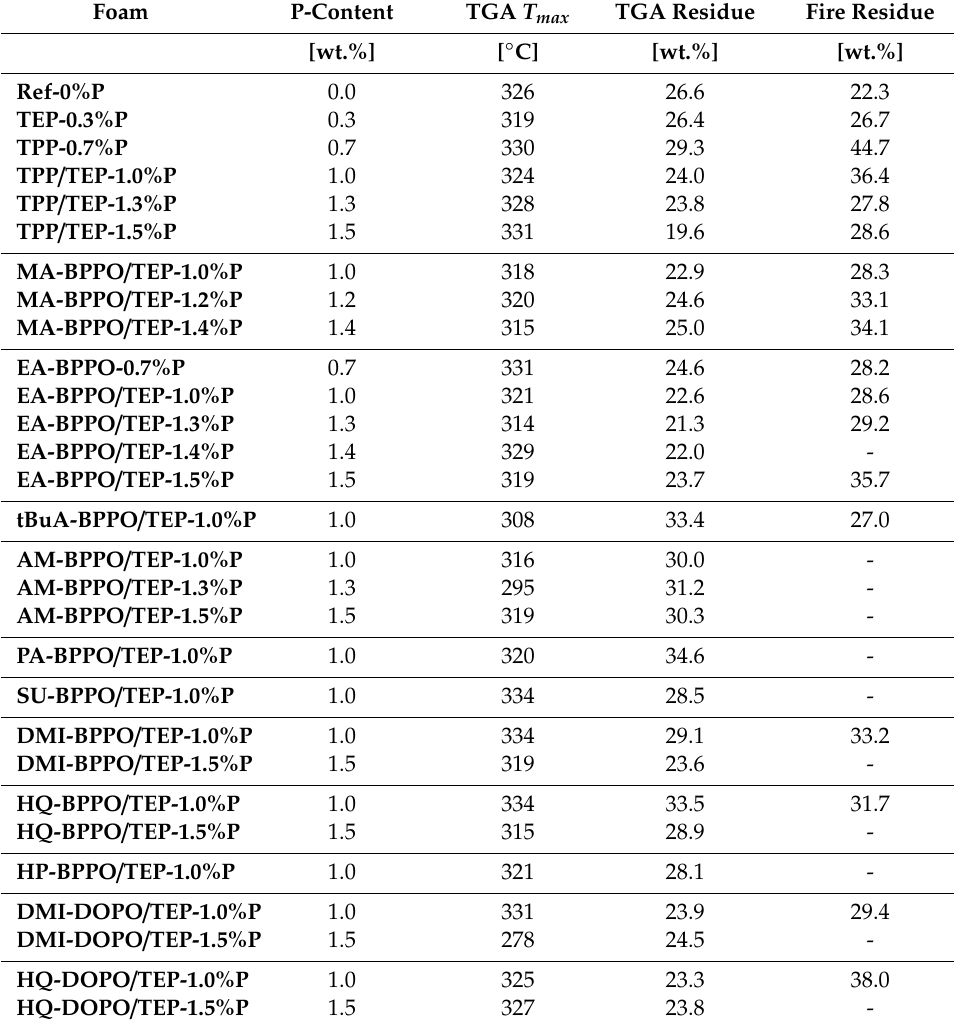
Table 5. Decompositioncharacteristicsofthestudiedfoams(descriptionofmethods: seeExperimentalpart). Foam